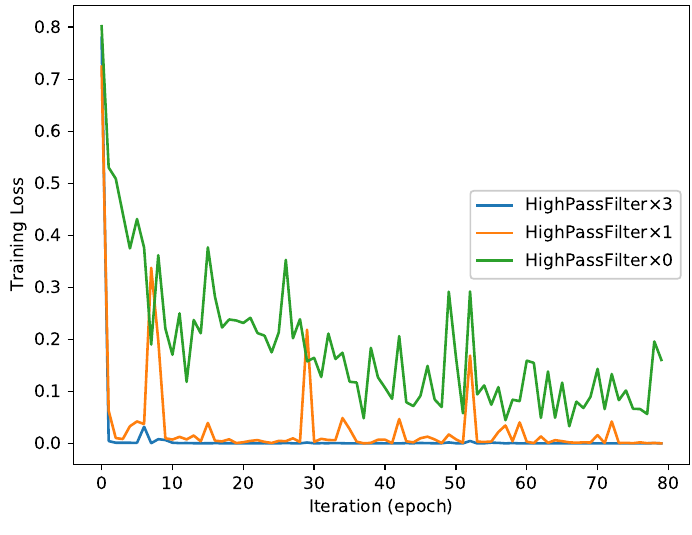
Figure 5. Training loss of the proposed